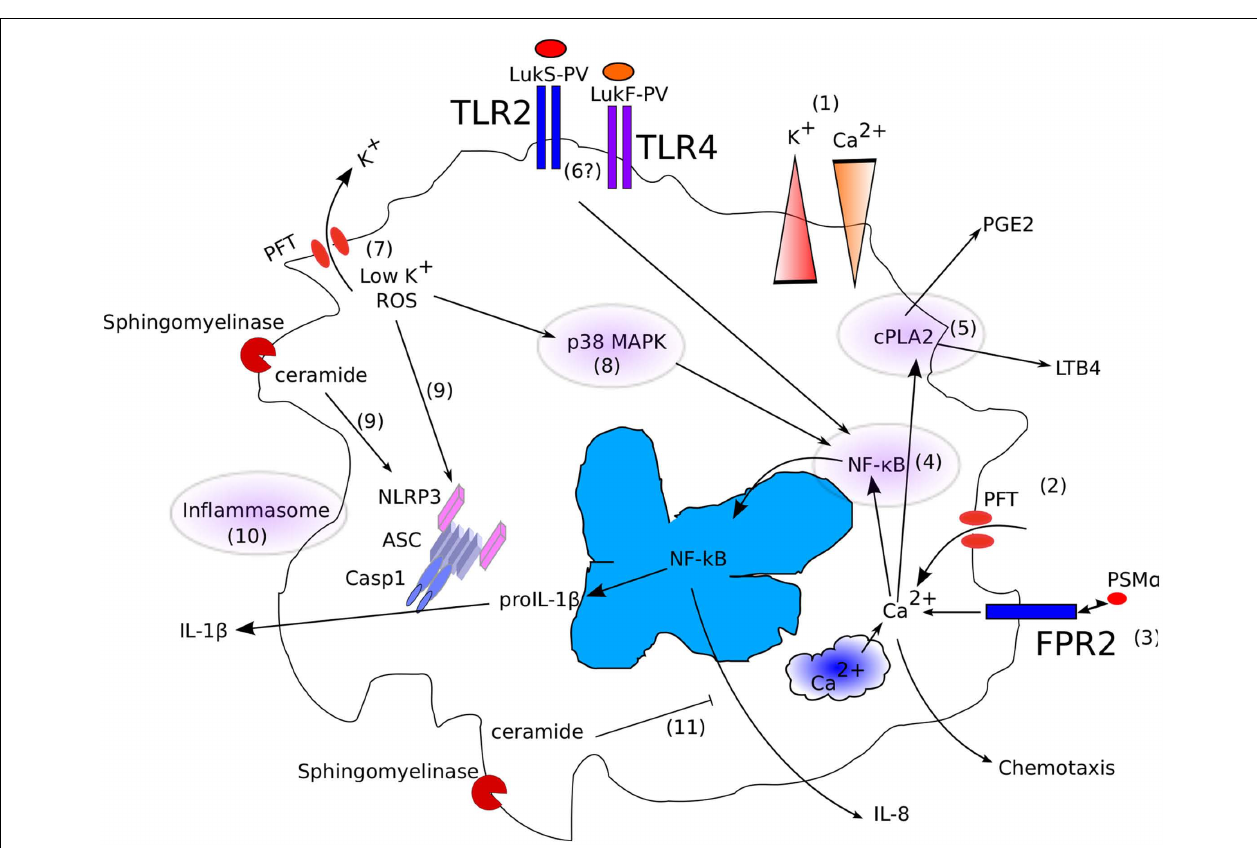
and 4 might also trigger NF- κ B translocation in the nucleus by sensing LukS-PV and LukF-PV. (7) Insertion of a PFT or membrane damage leads to a rapid fall in [K + ] i , leading to (8) MAP kinase and (9) NLRP3 inflammasome activation. (10) Ceramide generated by β -hemolysin might also directly activate the NLRP3 inflammasome. (11) In addition, ceramide has been reported to inhibit IL-8